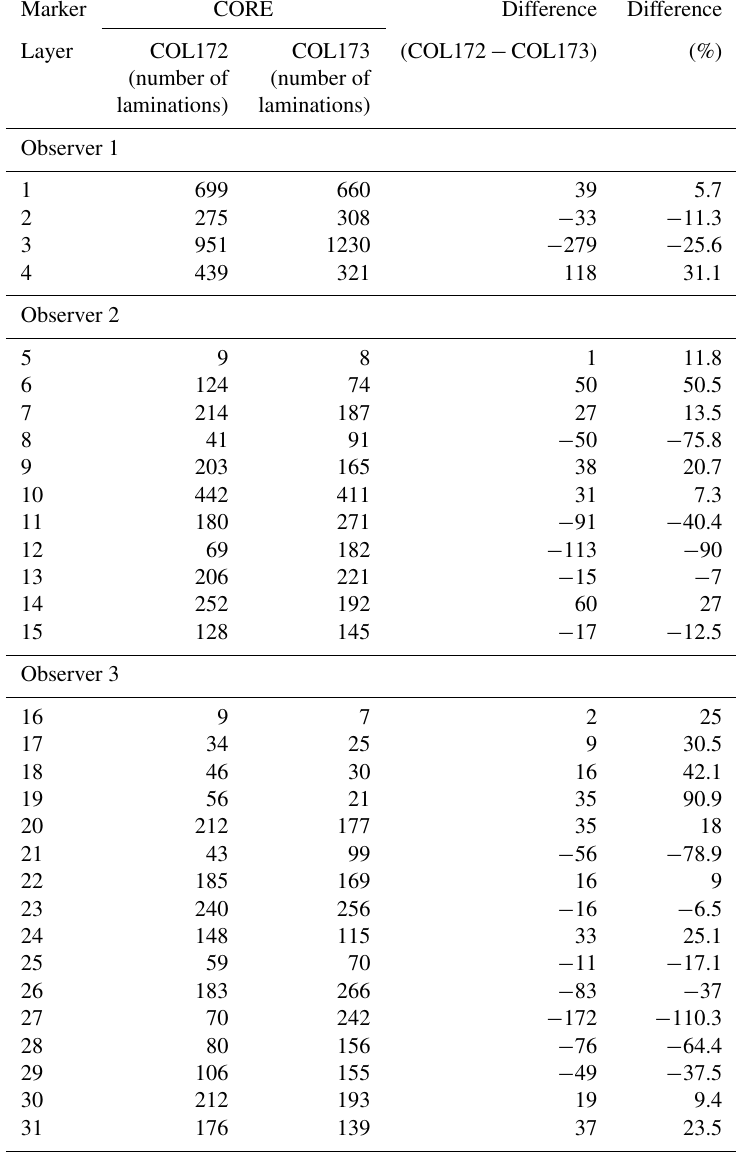
Table A1. Difference in the number of laminations between marker layers between cores for each observer. Note that marker layers do not cross-coordinate between observers, only between cores for each observer. Observers each used different marker layers. The difference is calculated as COL172 minus COL17-3. For example, marker layer 1 for observer 1 was found at lamination 699 in COL17-2 and at lamination 660 in COL17-3, indicating a difference of 39